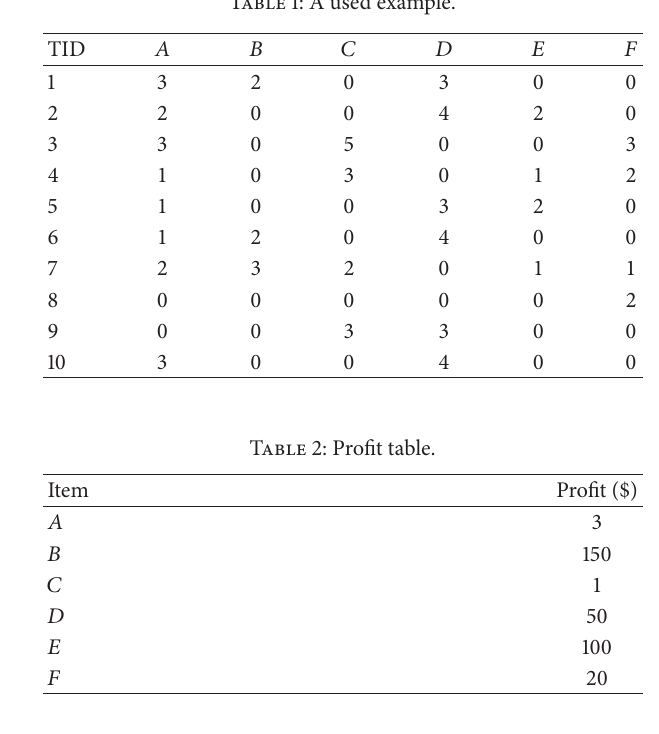
Table 1: A used example.